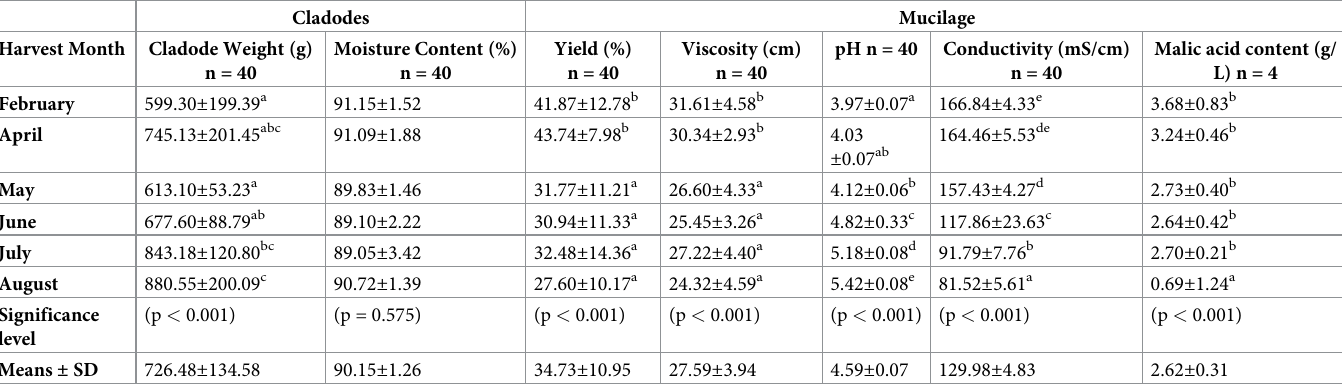
Table 1. The weight and moisture content of cladodes harvested over six months (February to August 2015) and the yield, viscosity (Line-spread), pH, conductivity and malic acid content of mucilage extracted from cladodes over six months (February to August 2015). Cladodes